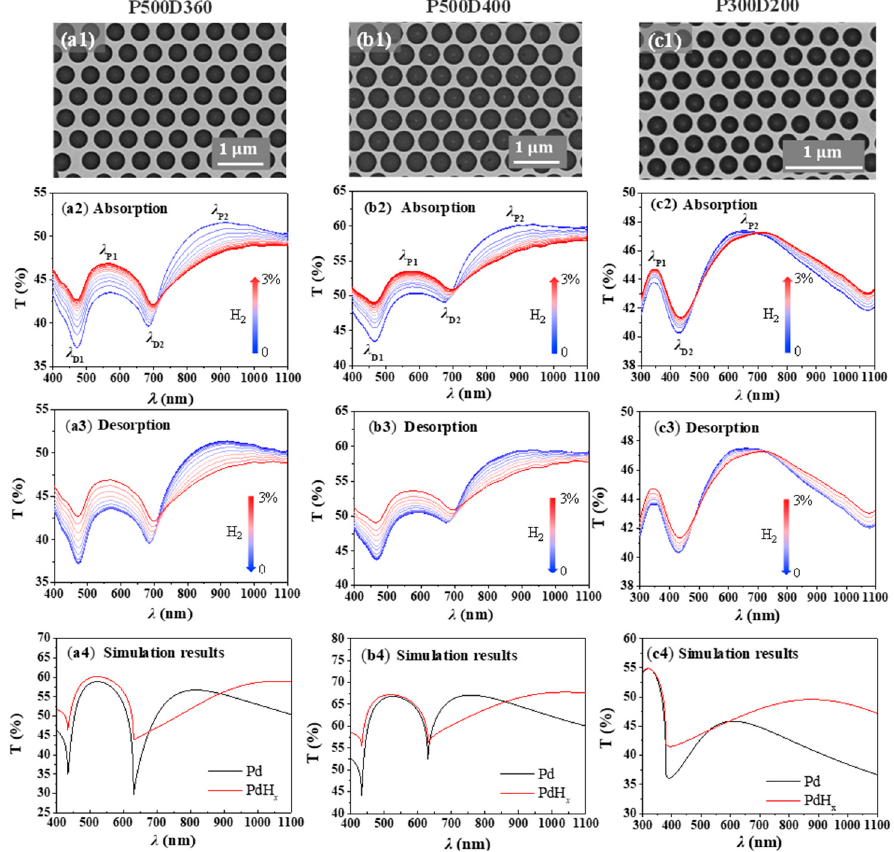
Figure 2. Optical transmission spectra and FDTD simulation results of Pd NHA samples upon hydrogen absorption and desorption processes: ( a1 – a4 ) P500D360; ( b1 – b4 ) P500D400; ( c1 – c4 ) P300D200.